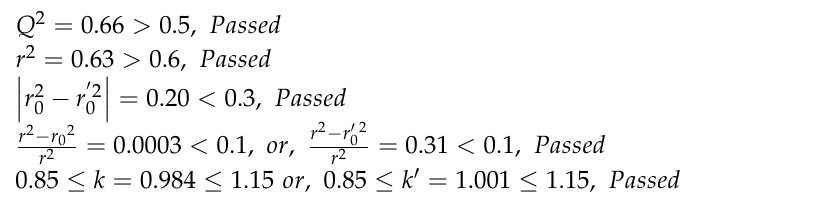
Table 3. Calculated square correlation among the modeled descriptors for Model 4.